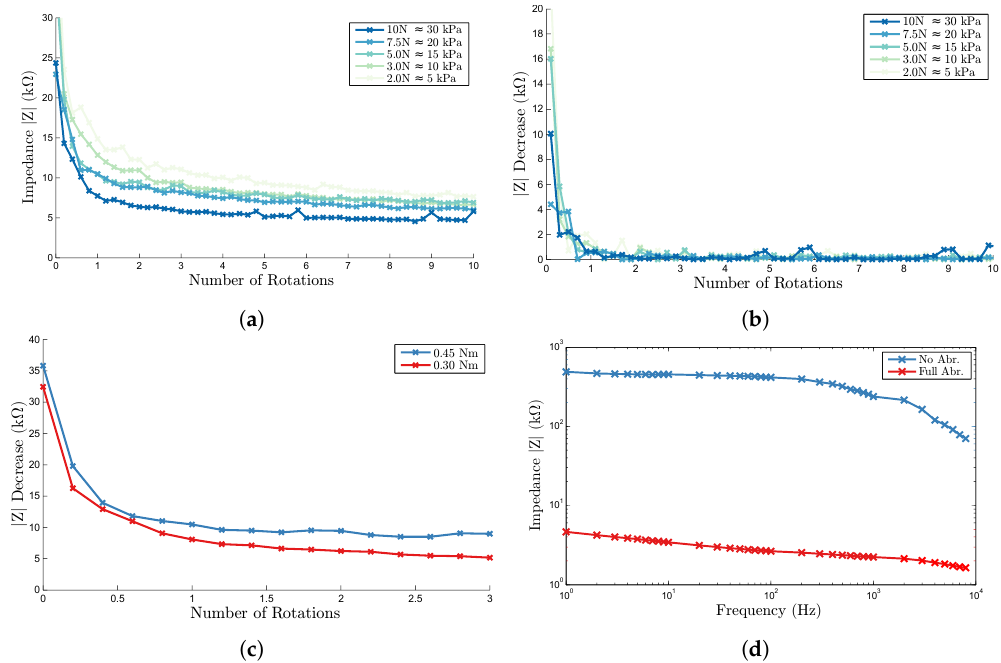
Figure 6. Automatic abrasion results ( a ) impedance decrease with electrode rotations across force range ( b ) impedance decrease per sixth of a rotation ( c ) comparison of impedance decrease for minimum and maximum torque ( d ) impedance spectra of orange skin test samples before and after